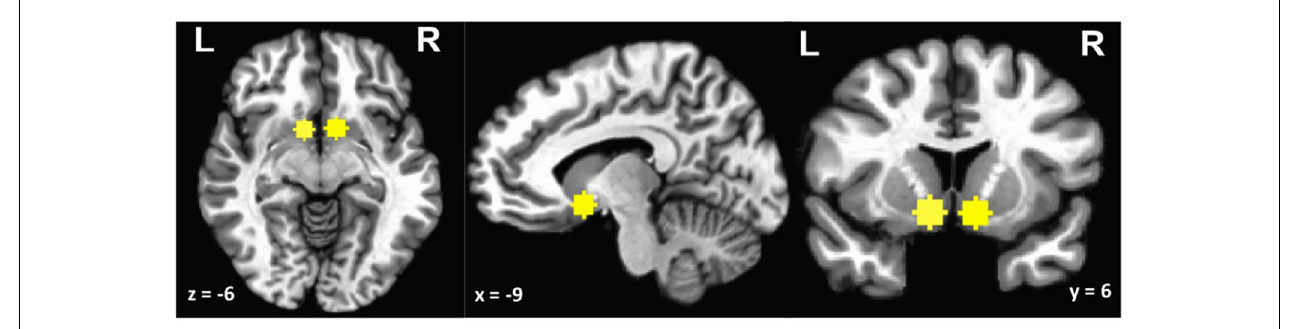
FIGURE 2 | Ventral striatum region of interest